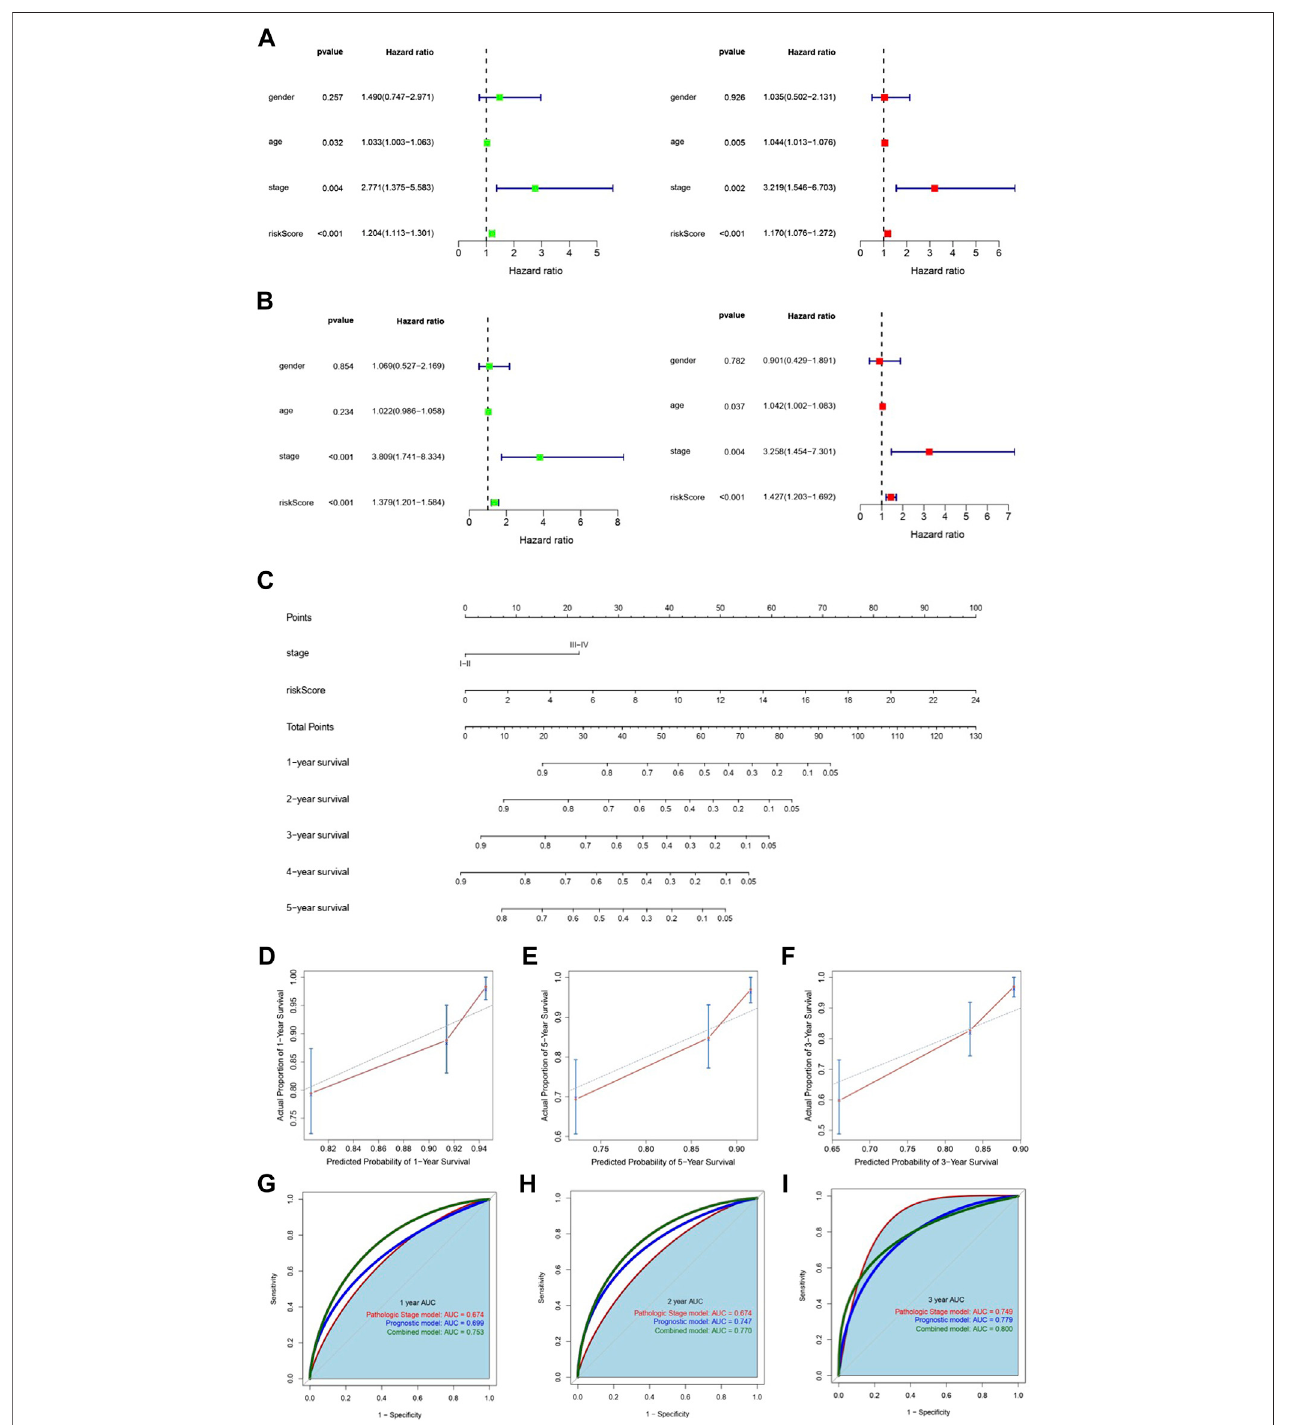
FIGURE 5 | Establishment and validation of the nomogram. (A,B) Univariate and multivariate regression analyses showed that m6A-LPS and pathological stage were independent prognostic predictors in both the training set (A) and testing set (B) . The left and right pictures represent the univariate analysis and multivariate analysis, respectively. (C) Nomogram combining m6A-LPS and stage. (D – F) Calibration curves for predicting 1-, 2-, and 3-year OS for patients with COAD. (D – F) Smooth ROC curves of 1-, 2-, and 3-year OS based on the pathological stage, m6A-LPS, and the nomogram.